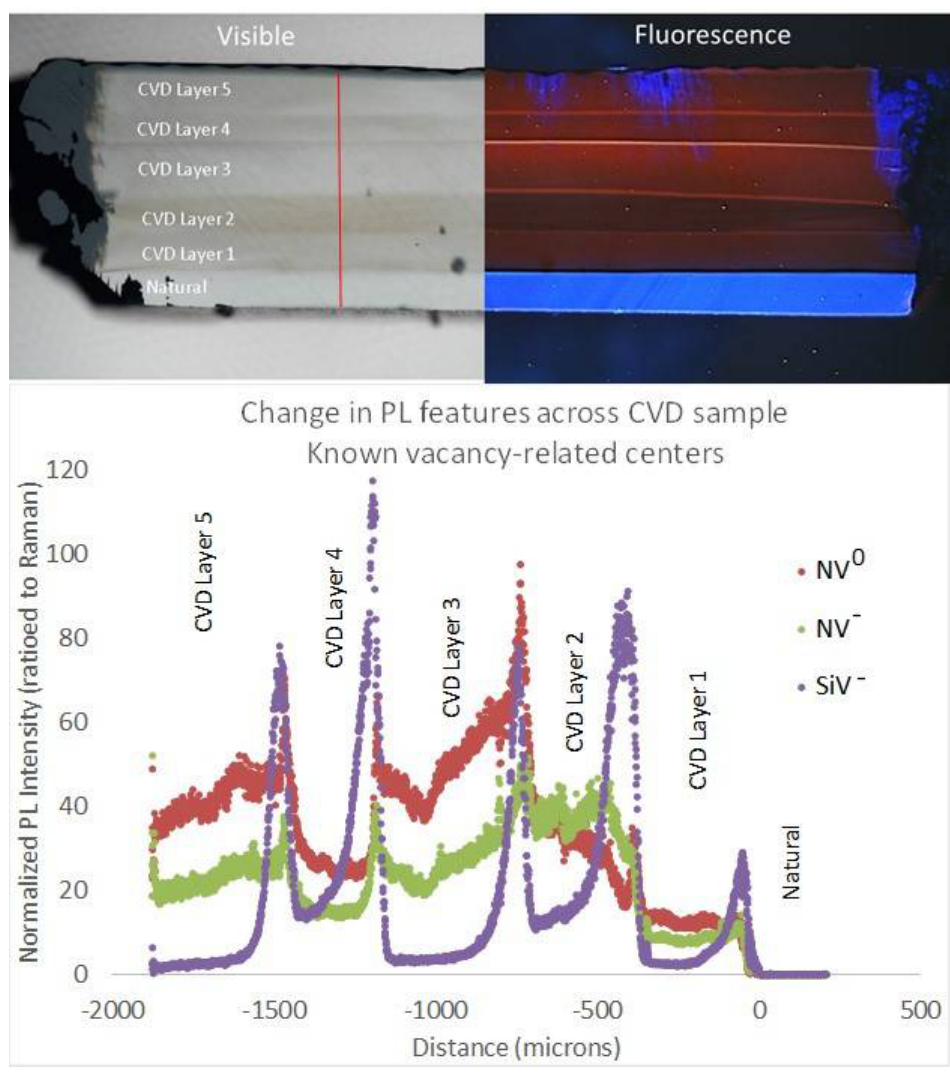
Figure 14. ( Top ) A thin laser-cut slice from a CVD-grown diamond composed of five different layers from five consecutive growth runs using a natural diamond substrate. The sample is shown with 2 types of illumination: visible and DiamondView (fluorescence) illumination, showing the distinct growth interfaces. ( Bottom ) Spectral data exported from the PL map (along the red line shown in top image) show the change in vacancy-related defects (NV 0 at 575 nm, NV - at 637 nm, and the negative silicon-vacancy defect at 737 nm) due to the growth interruptions.